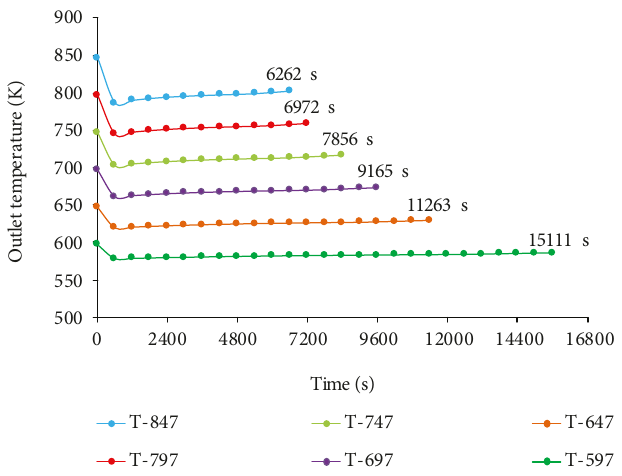
Figure 7: E ff ects of inlet temperature of HTF on outlet temperature of